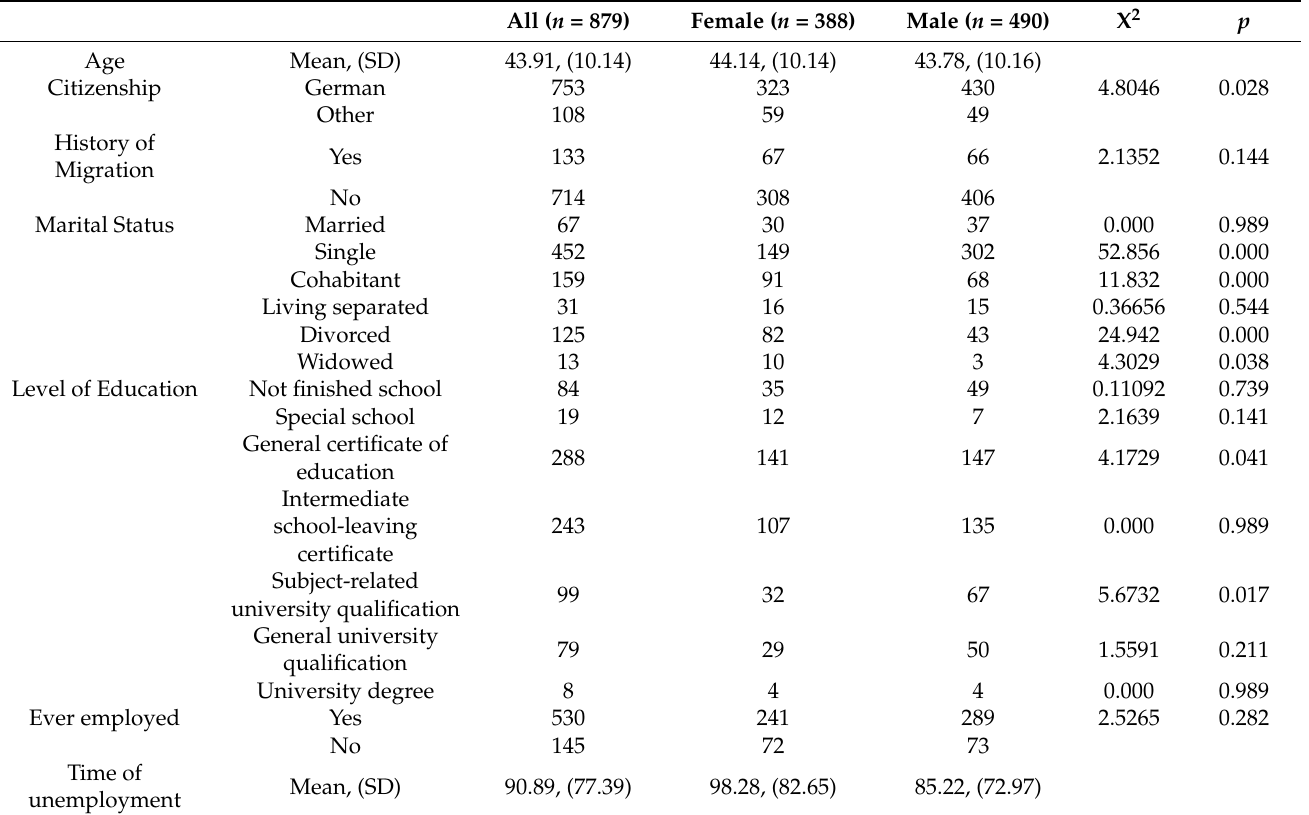
Table 1. Sociodemographic